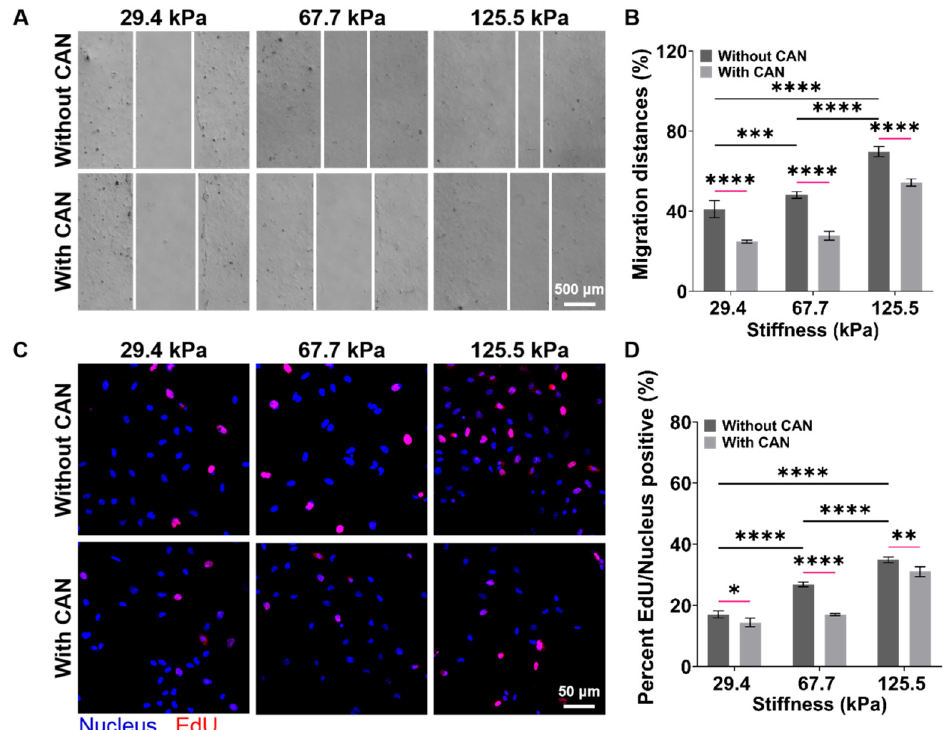
Figure 5. Characterization results of CF migration and proliferation behaviors on the PA gels with a stiffness of 29.4, 67.7, and 125.5 kPa. ( A ) Migration behavior of CFs on PA gels with different stiffness without and with CAN treatment. ( B ) Statistical histogram of CF migration rates ( n > 3). ( C ) Fluorescence images of CF EdU/Nucleus rates on PA gels with different stiffness without and with CAN treatment. ( D ) Statistical histogram of the CF EdU/Nucleus rates ( n > 3). Data are shown as means ± SEM. * p < 0.05, ** p < 0.01, *** p < 0.001, and **** p < 0.0001 determined by two-way ANOVA.